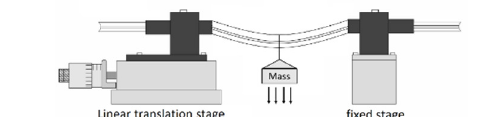
Fig. 3. Experimental setup to micro-force measurement with a pre- curvature LPG.